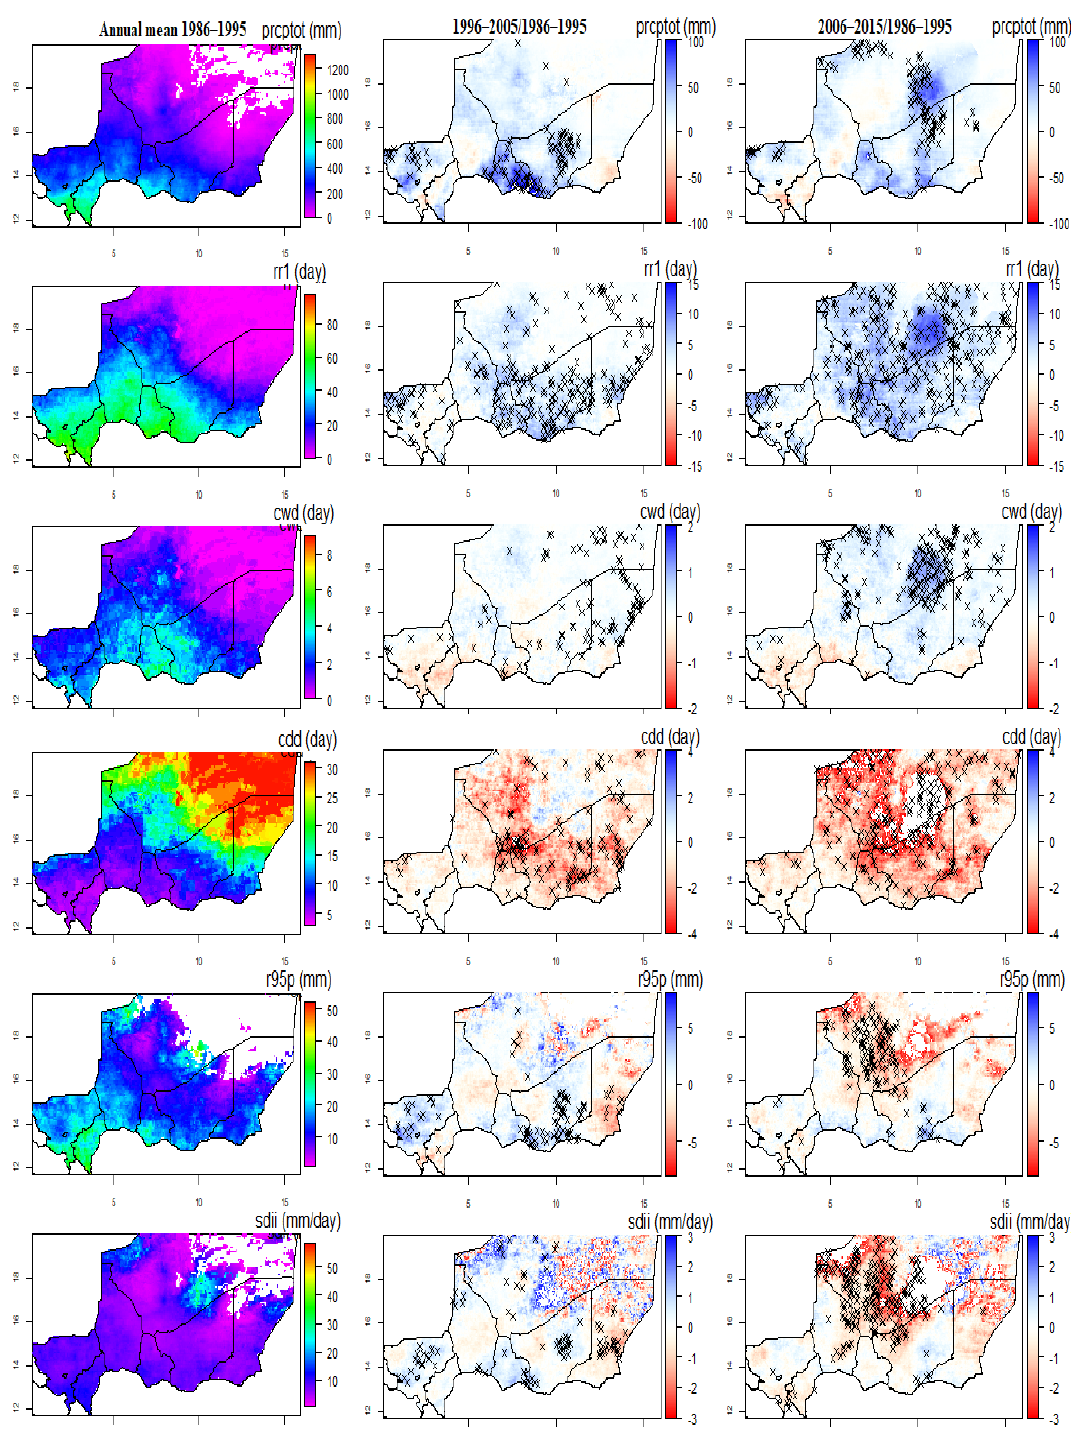
Figure 8. Spatial patterns of precipitation indices over Niger: mean over the reference decade 1986–1995 (first column); change over the 1996–2005 decade (second column) and changes over the 2006–2015 decade relative to reference decade (third column). Areas with the symbol (x) are significant at a 95% confidence level.